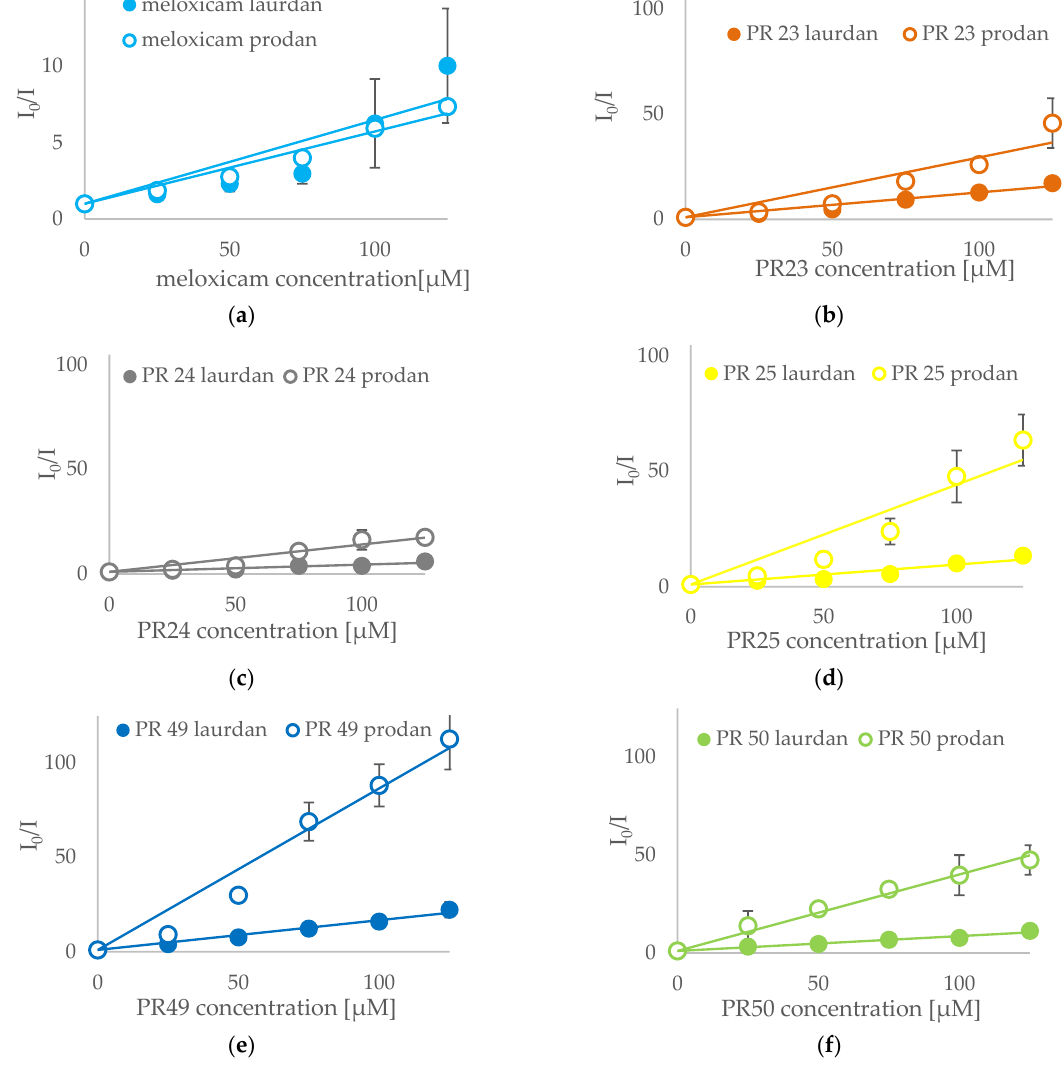
Figure 4. Stern–Volmer plots for: ( a ) meloxicam (reference compound)-induced quenching of laurdan (full symbols) and prodan (open symbols) fluorescence; ( b ) PR23 -induced quenching of laurdan (full symbols) and prodan (open symbols) fluorescence; ( c ) PR24 -induced quenching of laurdan and prodan fluorescence; ( d ) PR25 -induced quenching of laurdan and prodan fluorescence; ( e ) PR49 -induced quenching of laurdan and prodan fluorescence; ( f ) PR50 -induced quenching of laurdan and prodan fluorescence. Bars represent standard deviations of three independent experiments; where no error bars are shown, they were smaller than the symbols representing the results.